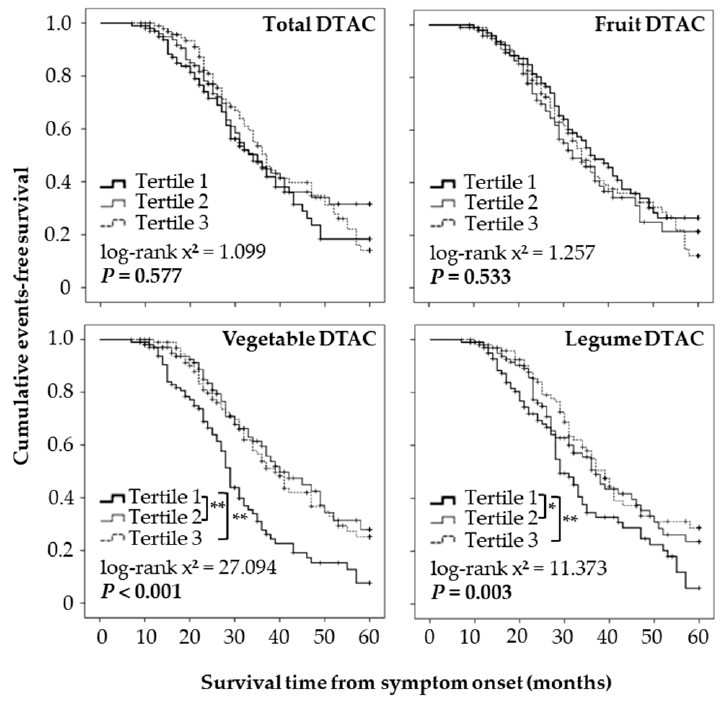
Figure 3. Kaplan–Maier survival curves showing 60-month survival according to the tertiles of the dietary total antioxidant capacity (DTAC). Statistical significance was determined using the log-rank test and the Kaplan–Meier method. * p < 0.05, ** p < 0.01.